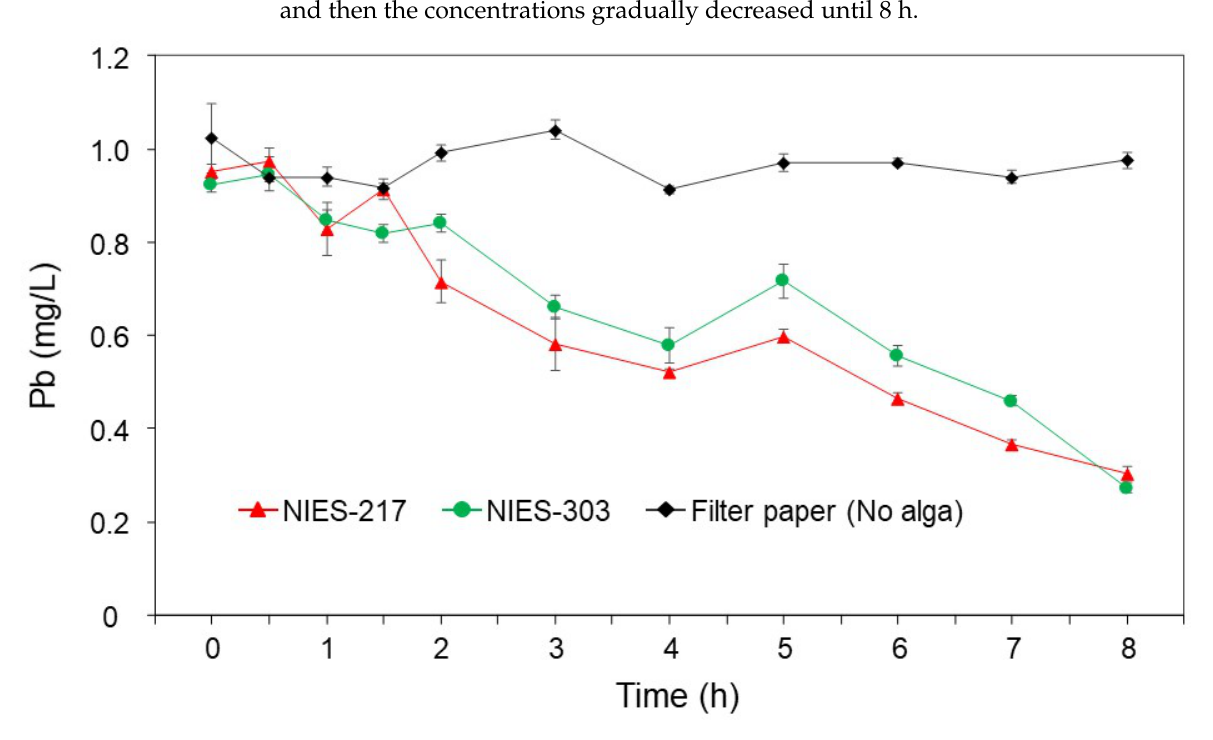
Figure 3. Time course of Pb concentration as the immobilized cells were soaked in the aqueous solution. Plots with an error bar show means ( n = 3) ± SD.